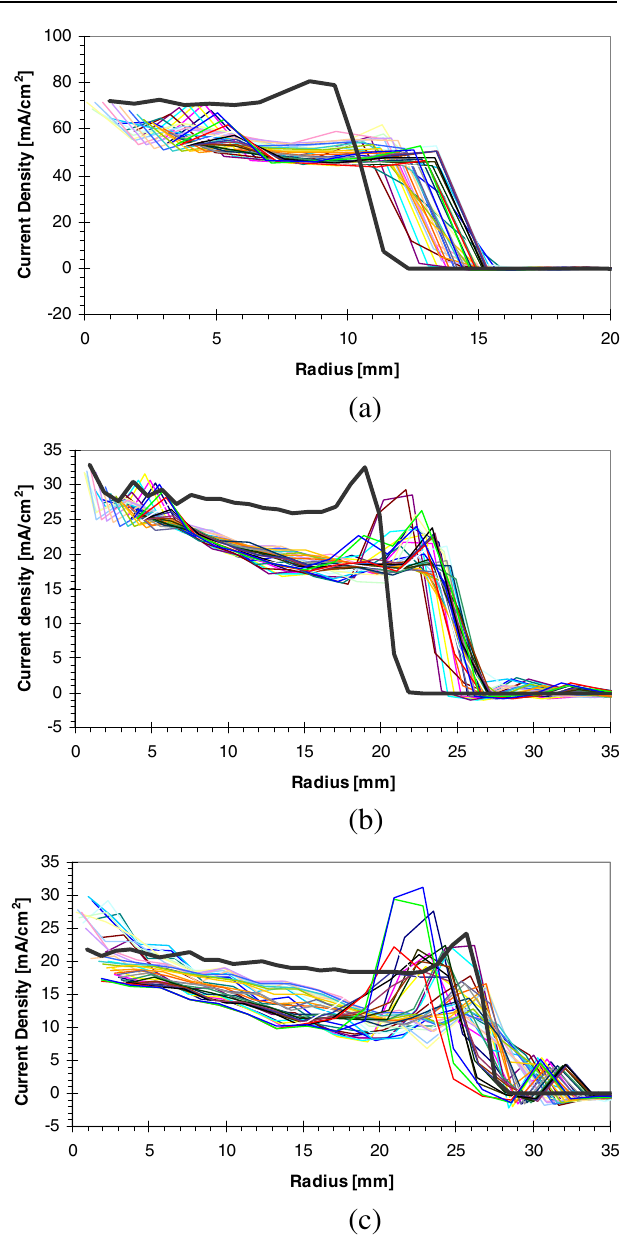
FIG. 8. (Color) Comparison of the measured and predicted (cid:5) 0 , 31, and 53.5 kV, respectively, radial beam profiles at V gate for a fixed Marx voltage of 509 kV. The thick black curve is the prediction from the WARP PIC